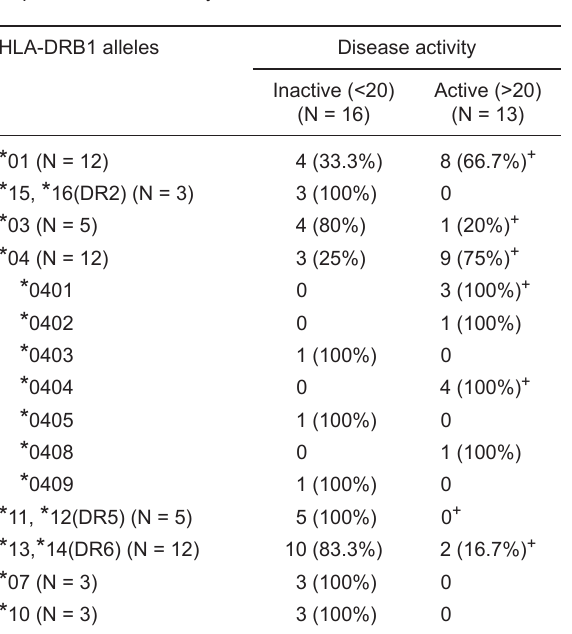
Table 4. HLA-DRB1 allele distribution among rheumatoid arthritis patients with active and inactive disease as determined by simplified disease activity index score.